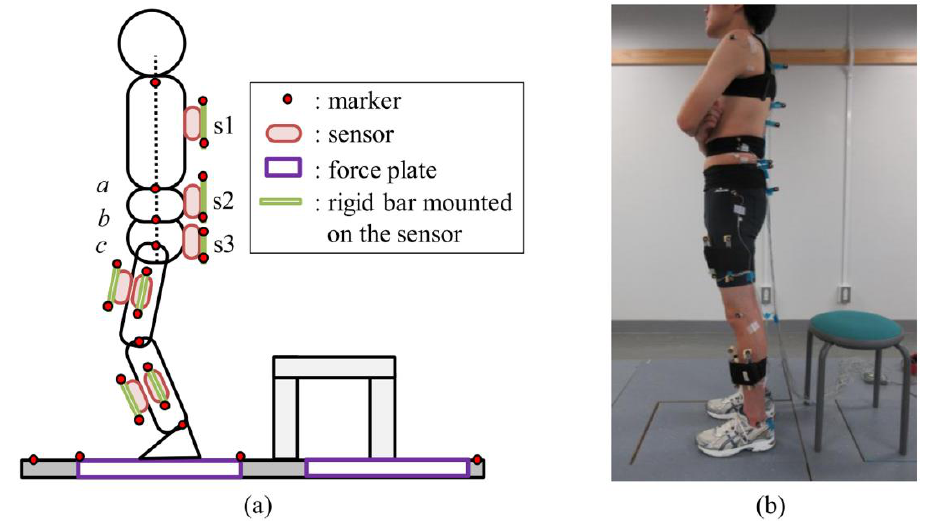
Figure 18. The experimental setup proposed by [76]. ( a ) Representation of body segments and sensors, ( b ) Landmarks and sensors worn by the subject.